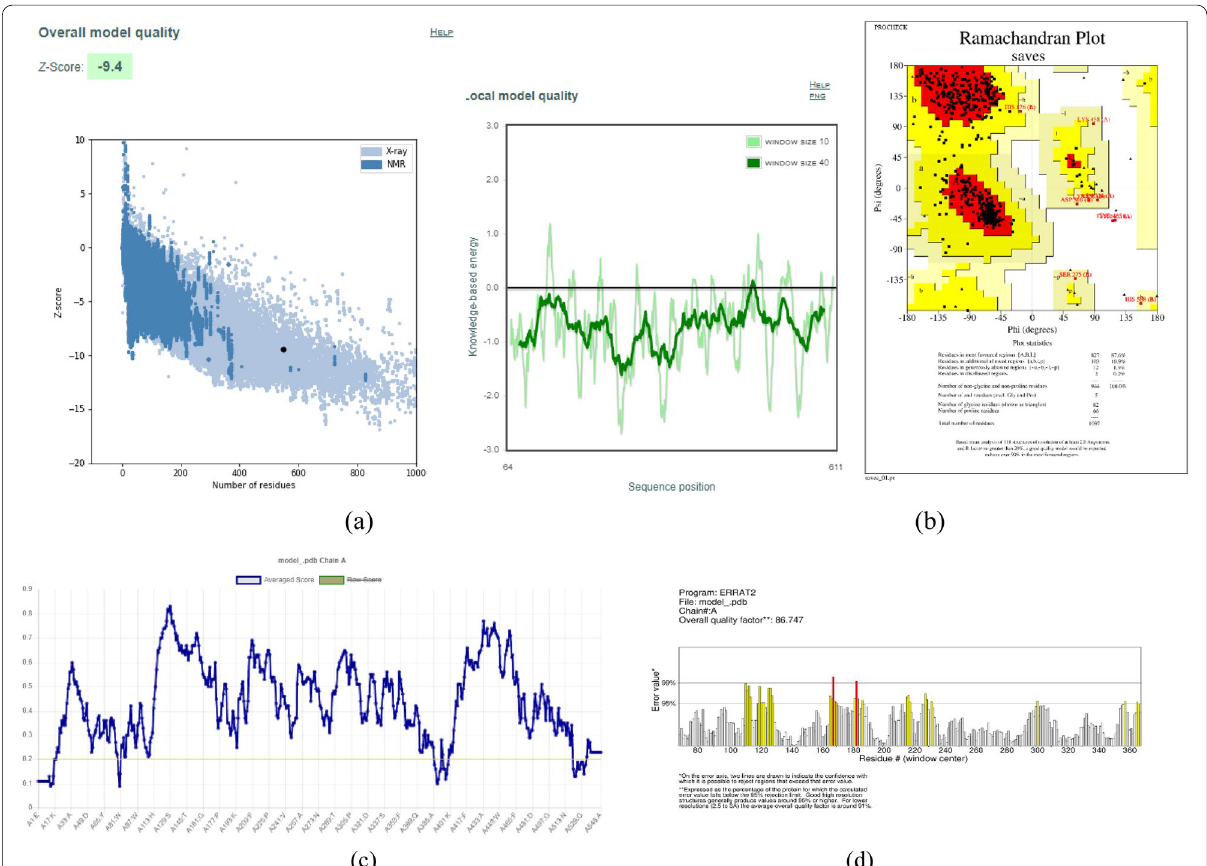
Fig. 2 a The overall and local quality of the A. pisum ’s AChE model predicted by the PROSA tool. b Ramachandran plot of the A. pisum ’s AChE model. c The local quality of the A. pisum ’s AChE model obtained by Verify 3D. d The non-bound interactions measure of the A. pisum ’s AChE model predicted by ERRAT